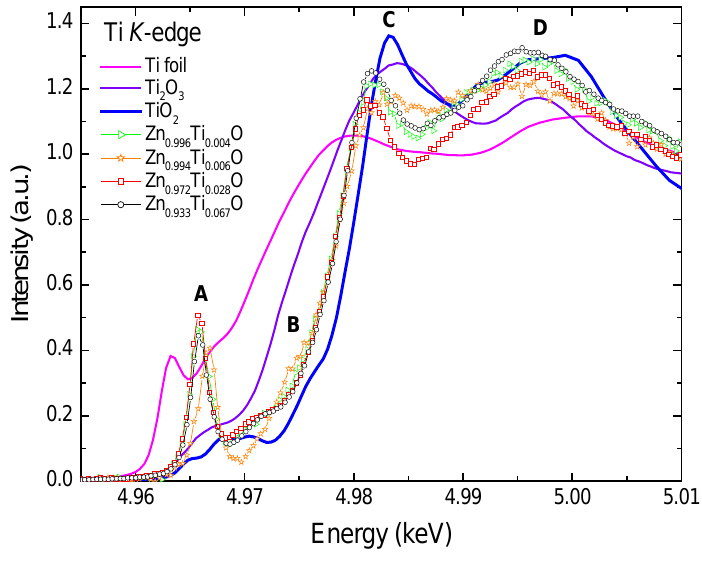
Figure 3. Normalized Ti K -edge XANES of Ti-doped ZnO films and reference samples, Ti foil, Ti O and TiO 2 3 2